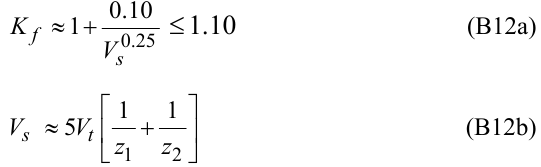
Basic Mesh Overload K )* Factor ( mo 1.00 1.10